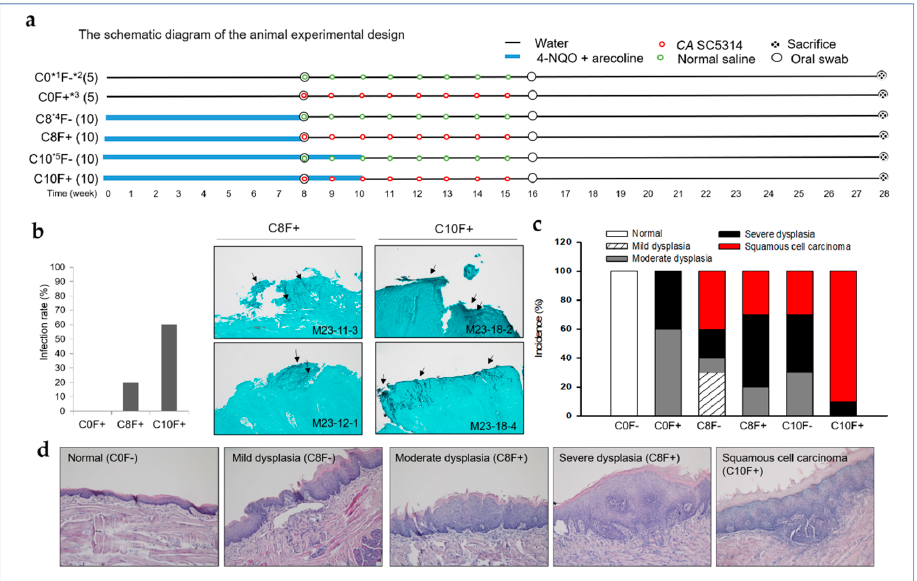
Figure 3. Oral infection of CA promotes the development of OSCC in mouse cotreated with 4-NQO and arecoline (NA). ( a ) The schematic diagram of the animal experimental design. ( b ) Histogram of CA SC5314 oral infection rate in mice groups. Oral swabs were collected at week 8, 16, and 28 and sent for microbial culture using CHROMagar Candida plates. Oral infection of CA SC5314 was determined with the oral swabs obtained at week 28. Representative GSM staining images of the CA -positive samples from C8F + and C10F + groups are shown. Arrows indicate the presence of fungi (black stained) in the samples. Magnification, × 100. ( c ) The bar chart plots percentage of pathological categories in tongue